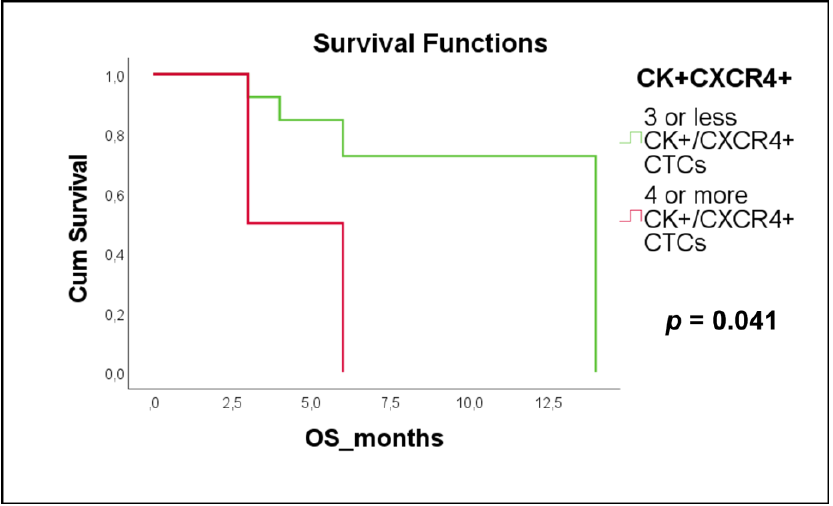
Figure 6. Kaplan – Meier survival curves for OS in SCLC patients with extensive disease related to the detection of CK+/CXCR4+ CTCs with cut-off at least 4 ( p = 0.041, HR = 5.01). No statistical clinical relevance has been identified regarding the rest of the exam- ined molecules and the corresponding phenotypes in SCLC patients.